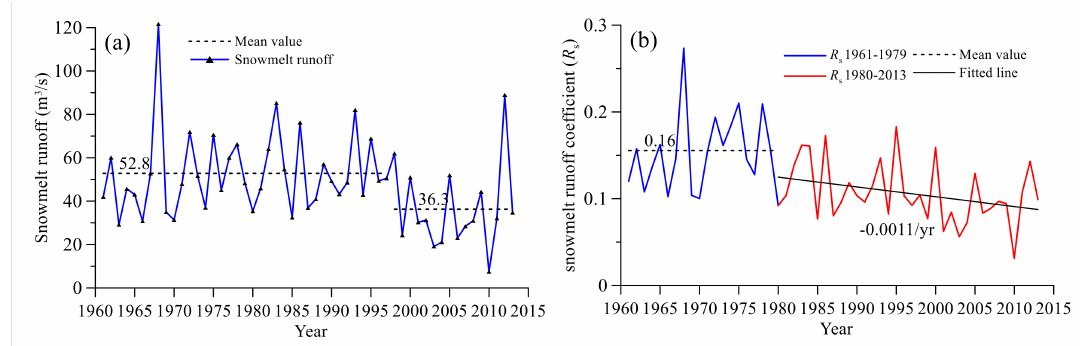
Figure 10. The inter-annual variation of ( a ) direct snowmelt runo ff and ( b ) direct snowmelt runo ff coe ffi cient ( R s